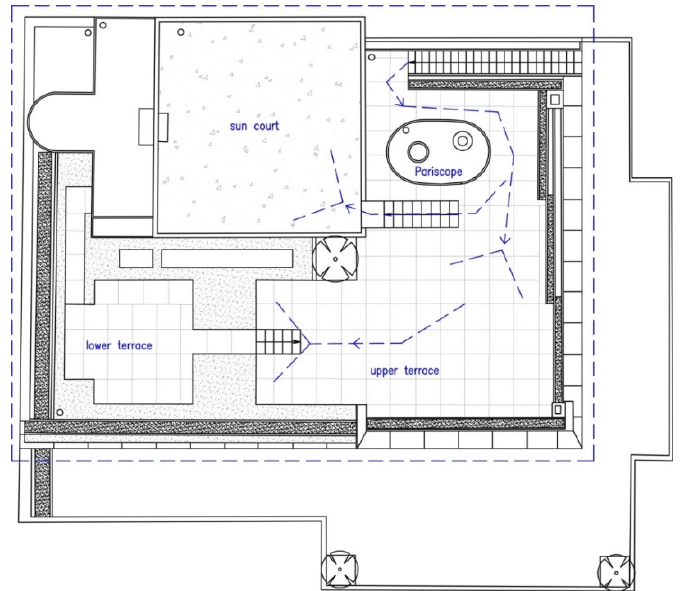
Figure 4. Apartment roof projection showing internal view relations—narrative guidance of the viewer. Own study